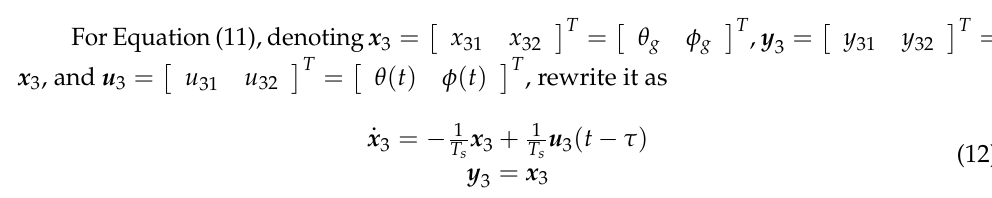
Figure 2. The seeker measurements under different time delays: ( a ) The measured LOS angles with lags and delays; ( b ) The measured LOS angular rates with lags and delays.